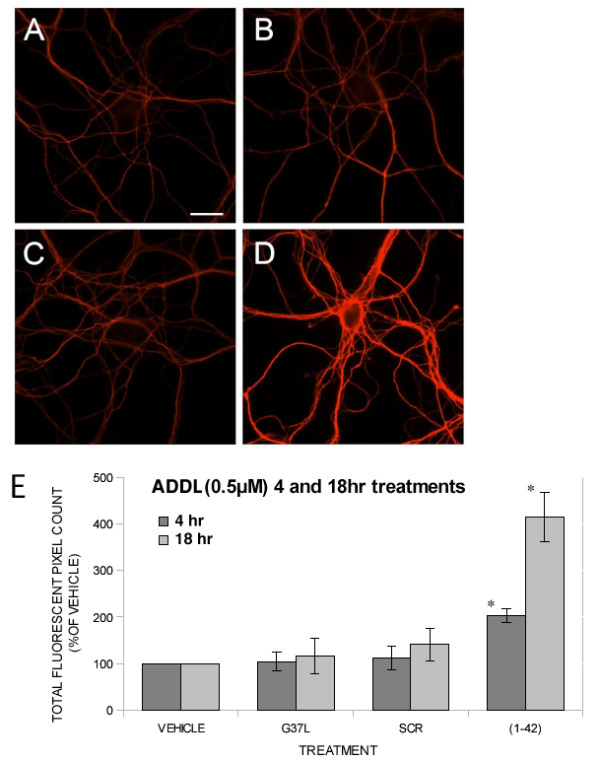
Effect of Aβ wild type and G37L ADDL exposure on tau hyperphosphorylation. A. - D. Representative epifluorescence images of cultured embryonic hippocampal neurons that were exposed for 18 hr to vehicle (A), 500 nM Aβ G37L ADDLs (B), 500 nM Aβ scrambled ADDLs (C), or 500 nM Aβ wild type ADDLs (D), then fixed and probed with anti-phospho tau monoclonal antibody PHF-1. Note strong increase in PHF-1 staining only in neurons treated with Aβ wild type ADDLs. E. Quantification of PHF-1 staining. Exposure to Aβ wild type produced significant increases in PHF-1 staining relative to control at 4 hr (204% ± 13; p = 0.0023; n = 5) and 18 hr (416% ± 48; p = 0.0041; n = 5); none of the other treatments significantly increased PHF-1 staining (Student's T-test, * P < 0.005).